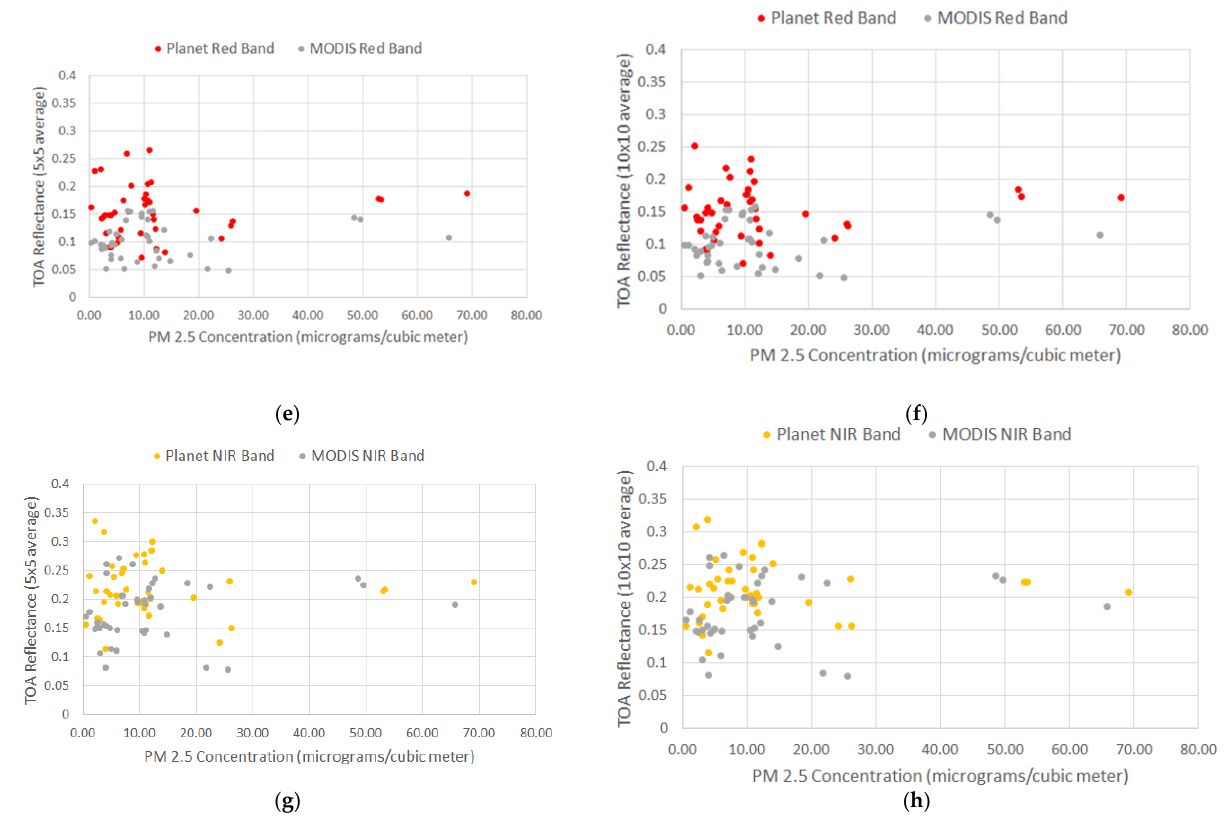
Figure 5. Three hour averaged PM 2.5 concentration on the x-axis plotted against ( a ) blue band TOA reflectance for a 5 × 5 pixel average; ( b ) blue band TOA reflectance for a 10 × 10 pixel average; ( c ) green band TOA reflectance for a 5 × 5 pixel average; ( d ) green band TOA reflectance for a 10 × 10 pixel average; ( e ) red band TOA reflectance for a 5 × 5 pixel average; ( f ) red band TOA reflectance for a 10 × 10 pixel average; ( g ) NIR band TOA reflectance for a 5 × 5 pixel average; ( h ) NIR band TOA reflectance for a 10 × 10 pixel average on the y-axis; for both PlanetScope and MODIS for all 41 data points. PlanetScope points are in color and MODIS points are grey.